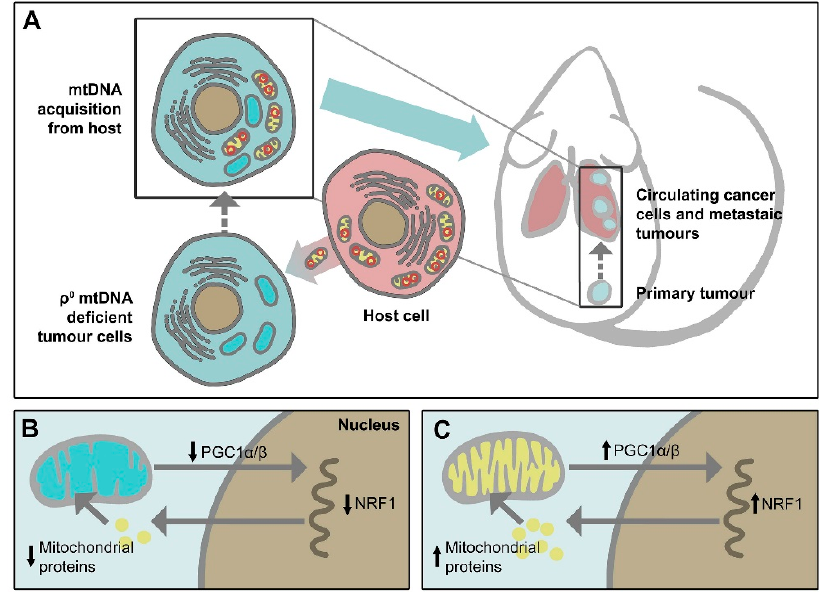
Figure 1. Mitochondrial transfer from host cells leads to tumorigenesis recovery of mtDNA-depleted cancer cells. ( A ) mtDNA deficient ρ 0 cancer cells do not form tumours. mtDNA acquisition from host cells leads to recovery of tumorigenic capacity of the cells. ( B ) In mtDNA deficient ρ 0 cancer cells, signalling between mitochondria and nucleus is dampened. Reduced levels of the transcription coactivator PGC1 α / β leads to the low transcriptional activity of nuclear respiratory factor-1 (NRF1), resulting in the low level of nuclear-encoded proteins imported into the mitochondria and mitochondrial dysfunction. ( C ) Mitochondrial transfer from host cells leads to increased PGC1 α / β levels with an increased NRF1 transcriptional activity. This allows appropriate levels of nuclear-encoded mitochondrial proteins to be imported into mitochondria and to recover mitochondrial function.